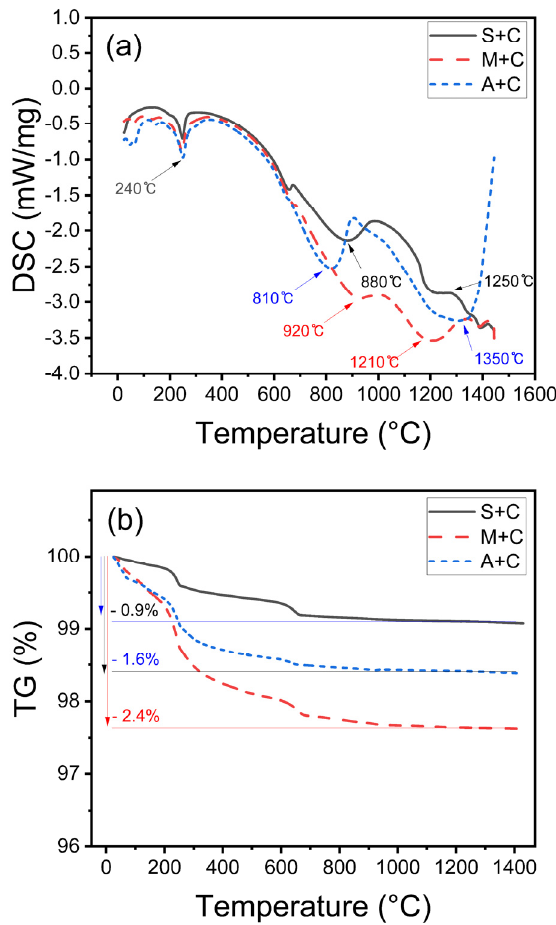
Figure 5. ( a ) DSC profiles of molded body, ( b ) TG profiles of molded body.